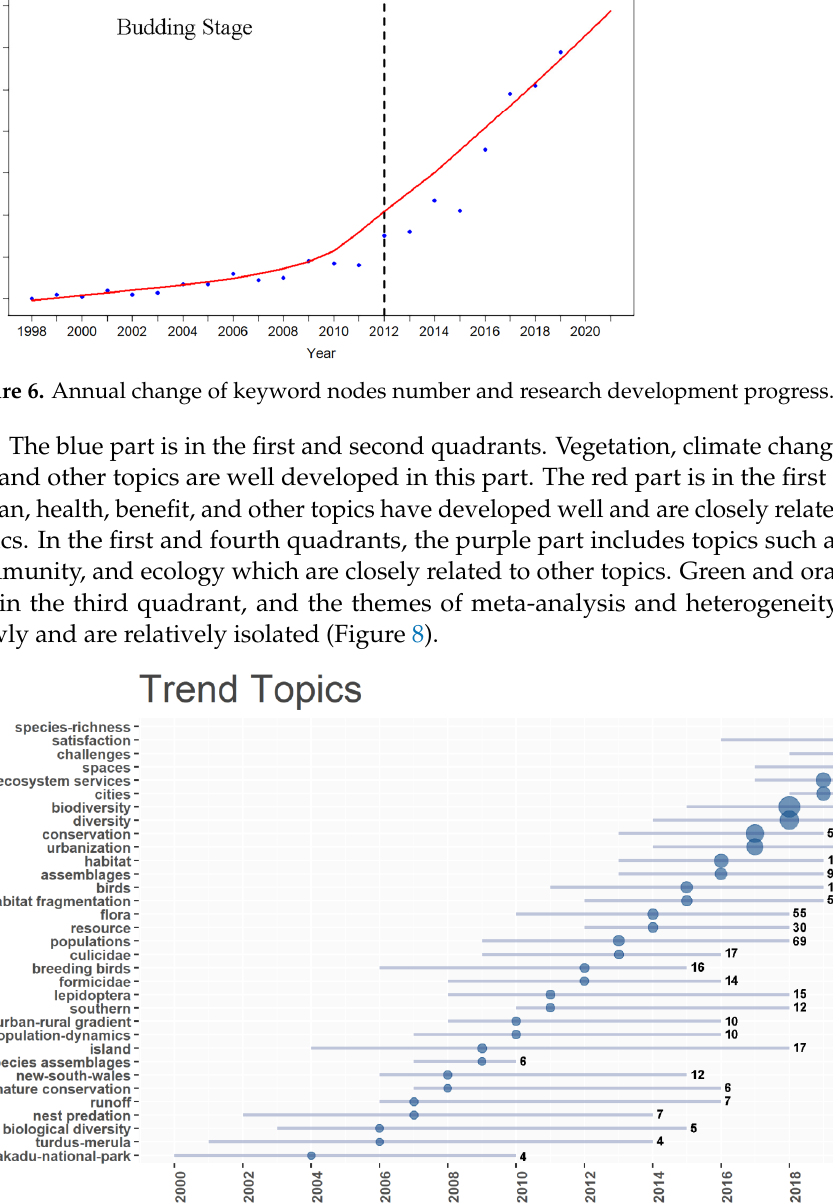
Figure 7. Keywords evolution. The horizontal line in the figure represents the time range when the occurrence frequency of a keyword is greater than four, and the circle represents the highest occurrence frequency in that year. The larger the circle, the higher the corresponding occurrence frequency. The number after each line represents the value in the